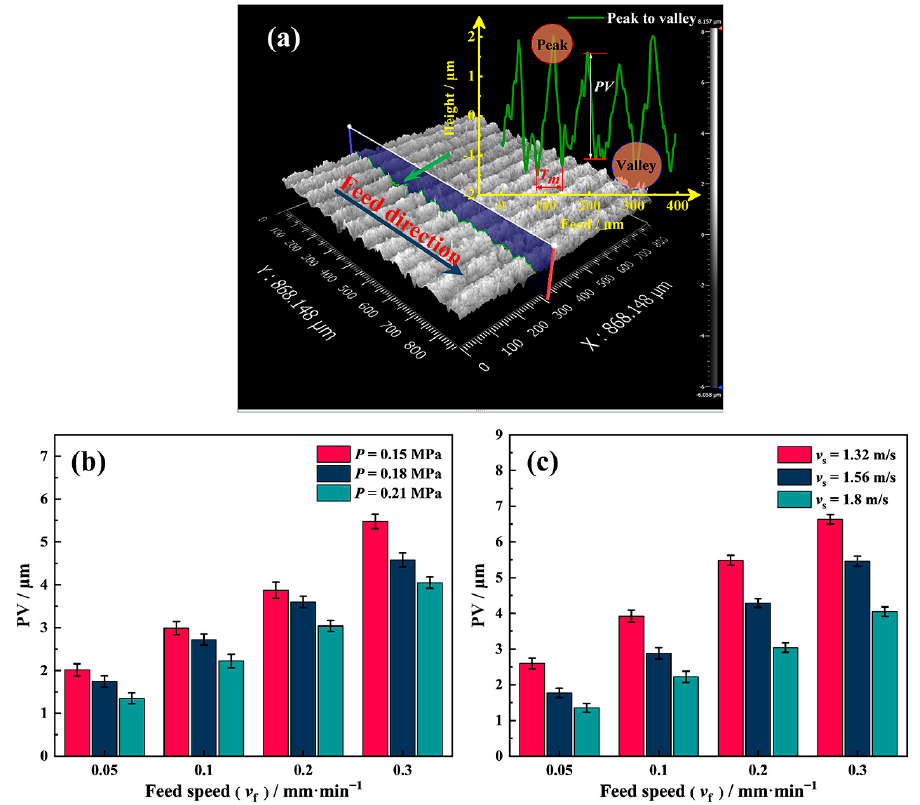
Figure 9. ( a ) Schematic illustration of the PV measurement; ( b ) the effect of the wire tension on the PV value, and ( c ) the effect of the wire speed on the PV